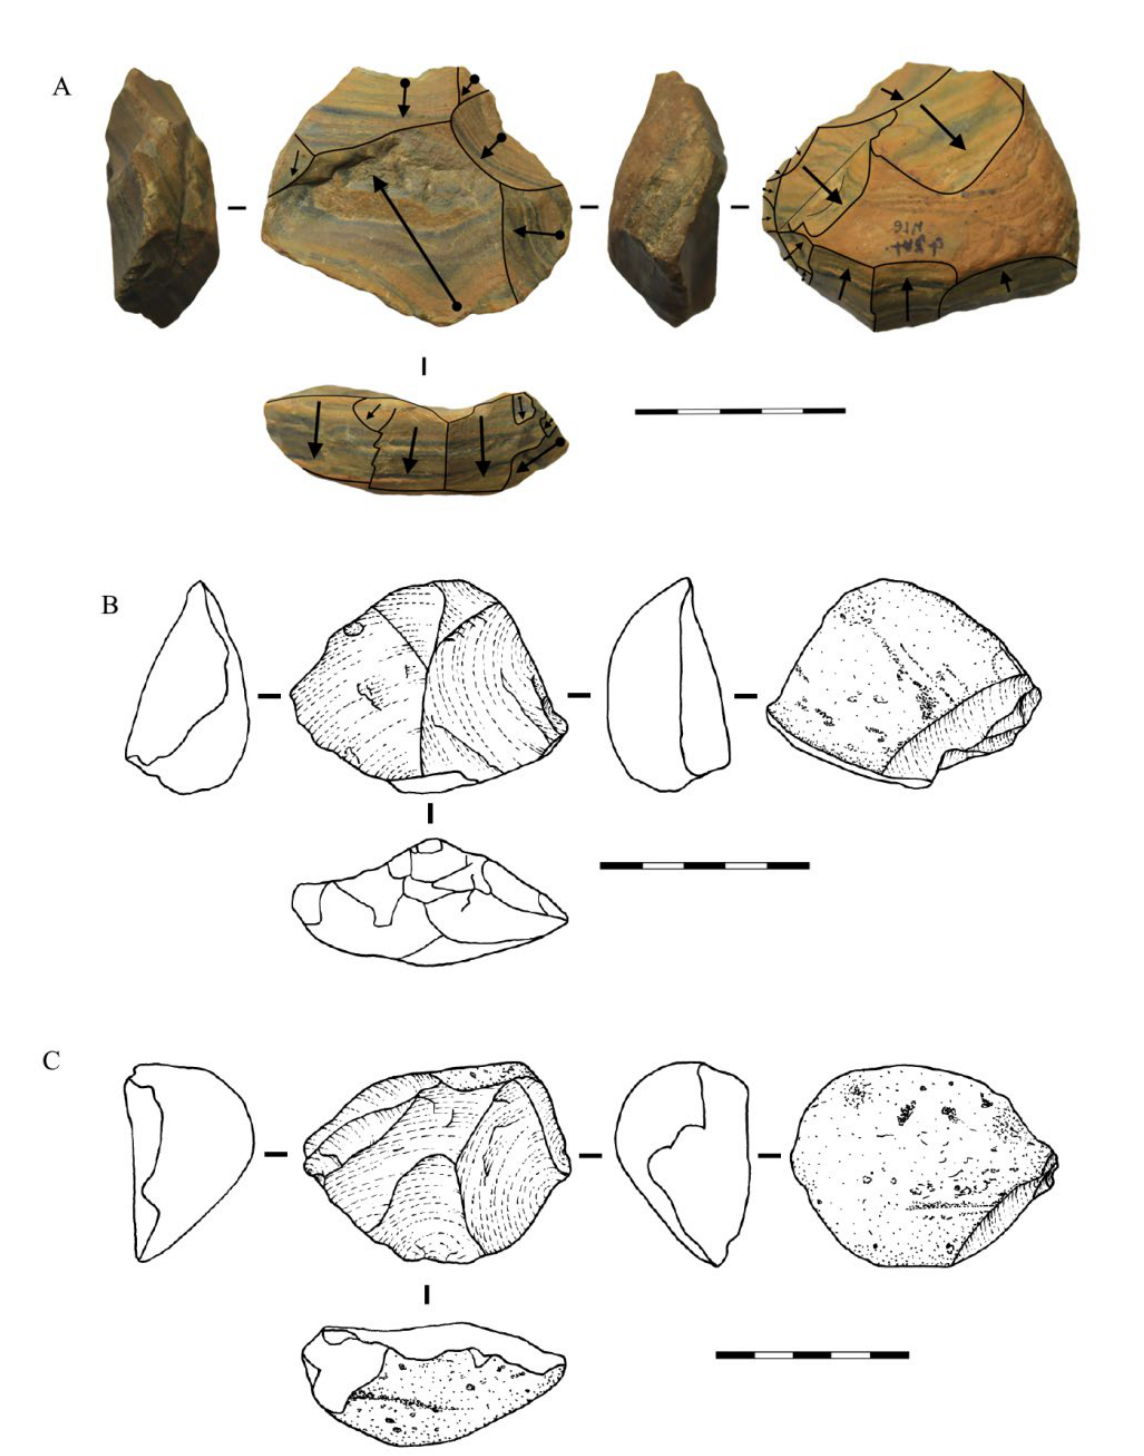
Figure 9. Levallois (A) and typo-Levallois (B and C) cores of Saint-Saturnin. A: Jaspoid; B and C: Quartzite. Scale bar: 5